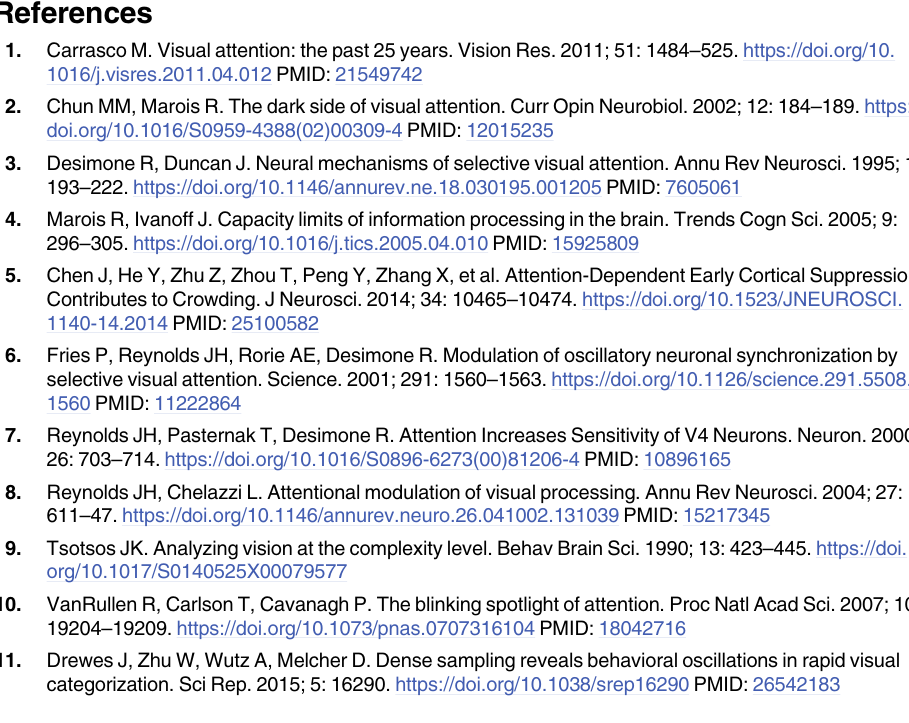
S8 Data. Data for S4 Fig. (XLSX) S9 Data. Data for S5 Fig.